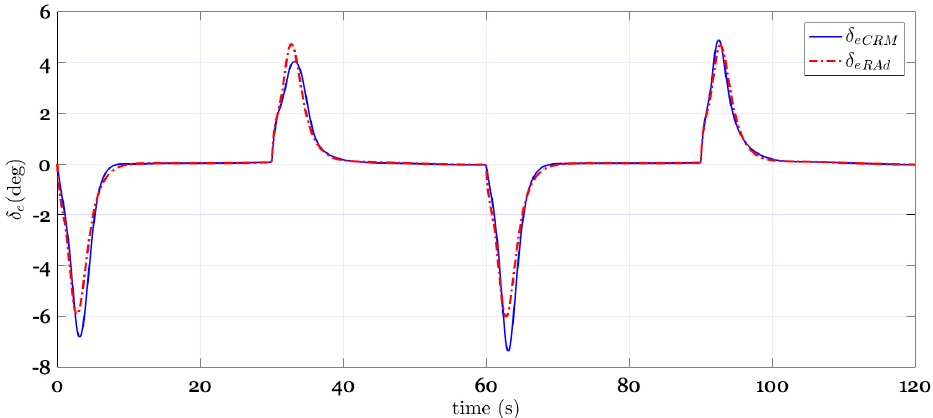
Figure 14. Control signal from CRM and robust adaptive controller with ρ λ = ρ θ = 10.